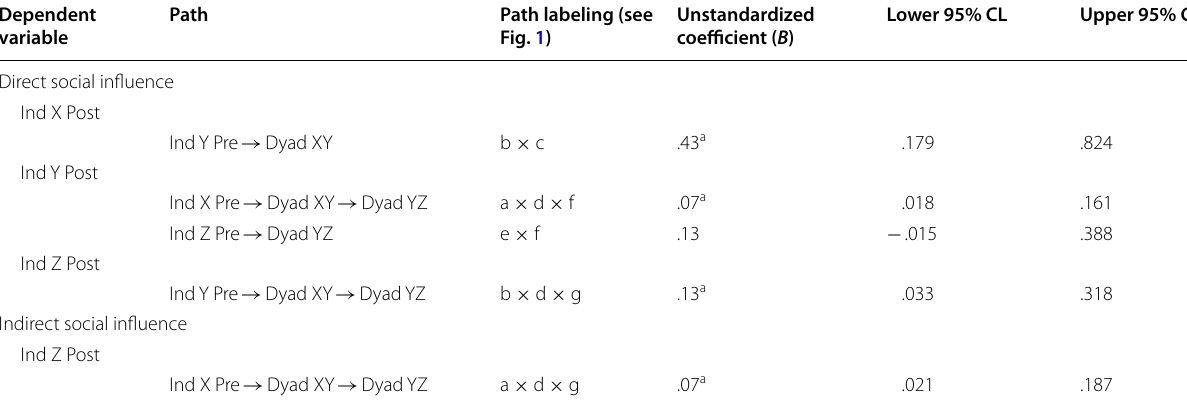
CL confidence limit. Confidence limits derived from 95% bias-corrected bootstrap confidience intervals based on 10,000 resamples. The significance of the path coefficients ( a ) was based on whether the confidence interval included zero or